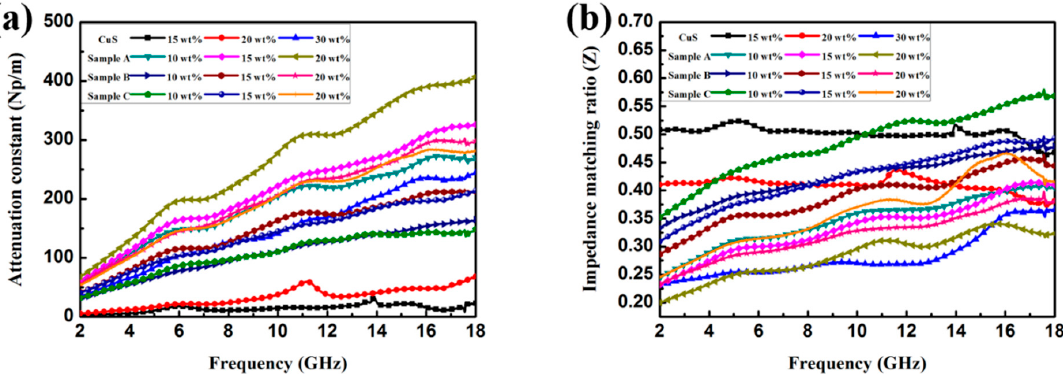
Figure 9. Frequency dependence of ( a ) attenuation constant ratio and ( b ) impedance matching for paraffin composites containing different loading ratios of CuS and CuS@PPy (polypyrrole) samples.